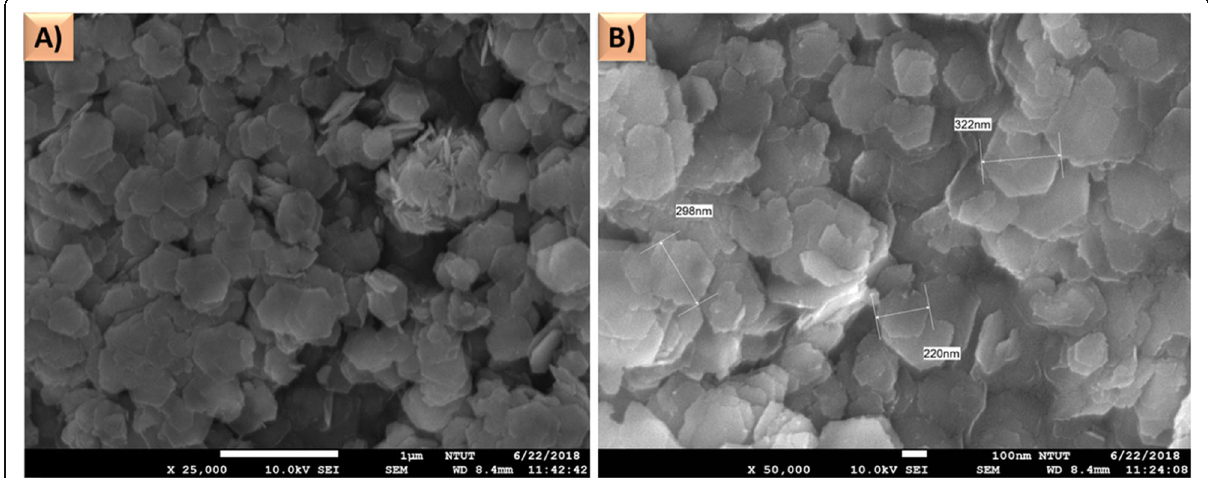
Fig. 4 a The FESEM images of SnS at different magnifications. b The nanoflakes have widths of approximate 322, 298, and 220